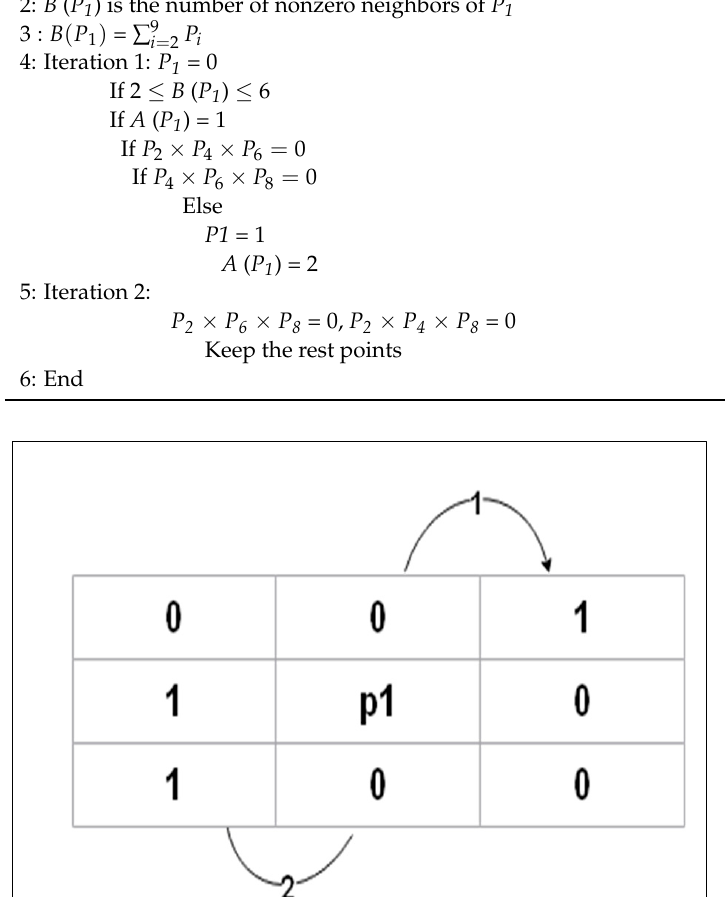
Figure 4. Counting the 01 patterns in the ordered set P2,…, P9 . Skeletonization is achieved by removing specific foreground pixels from a binary image through image thinning. Consequently, a collection of tiny arcs and curves portrays the signature pattern. The complement of the image is adjusted to make the signature bright and the background dark to skeletonize the original image. See Figures 5 and 6.